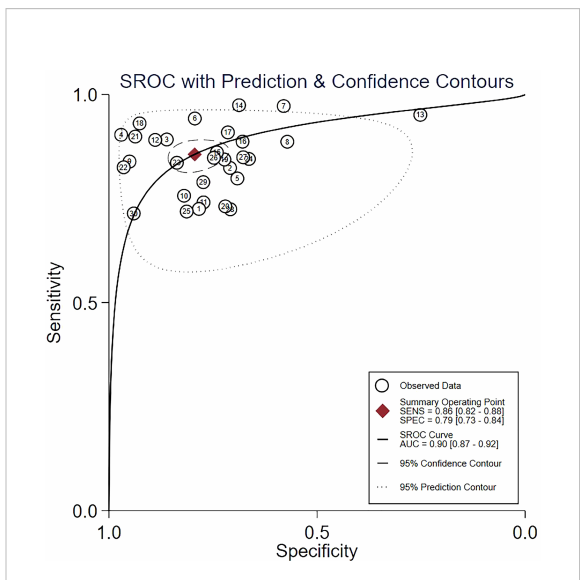
FIGURE 4 The summary receiver operating characteristic (SROC) curve of the diagnostic accuracy of radiomics in predicting ALNM in breast cancer. Each circle indicates one included study. Values in brackets are 95% CIs. AUC, area under the receiver operating characteristic curve.